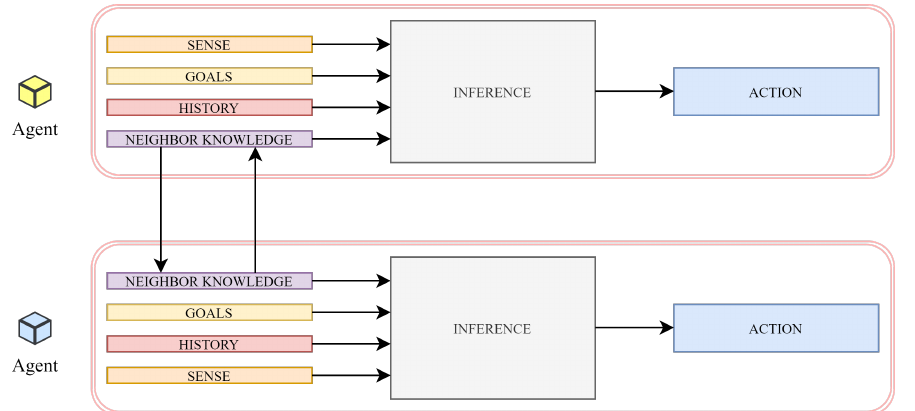
Figure 1. General structure of agent forming multi-agent system.